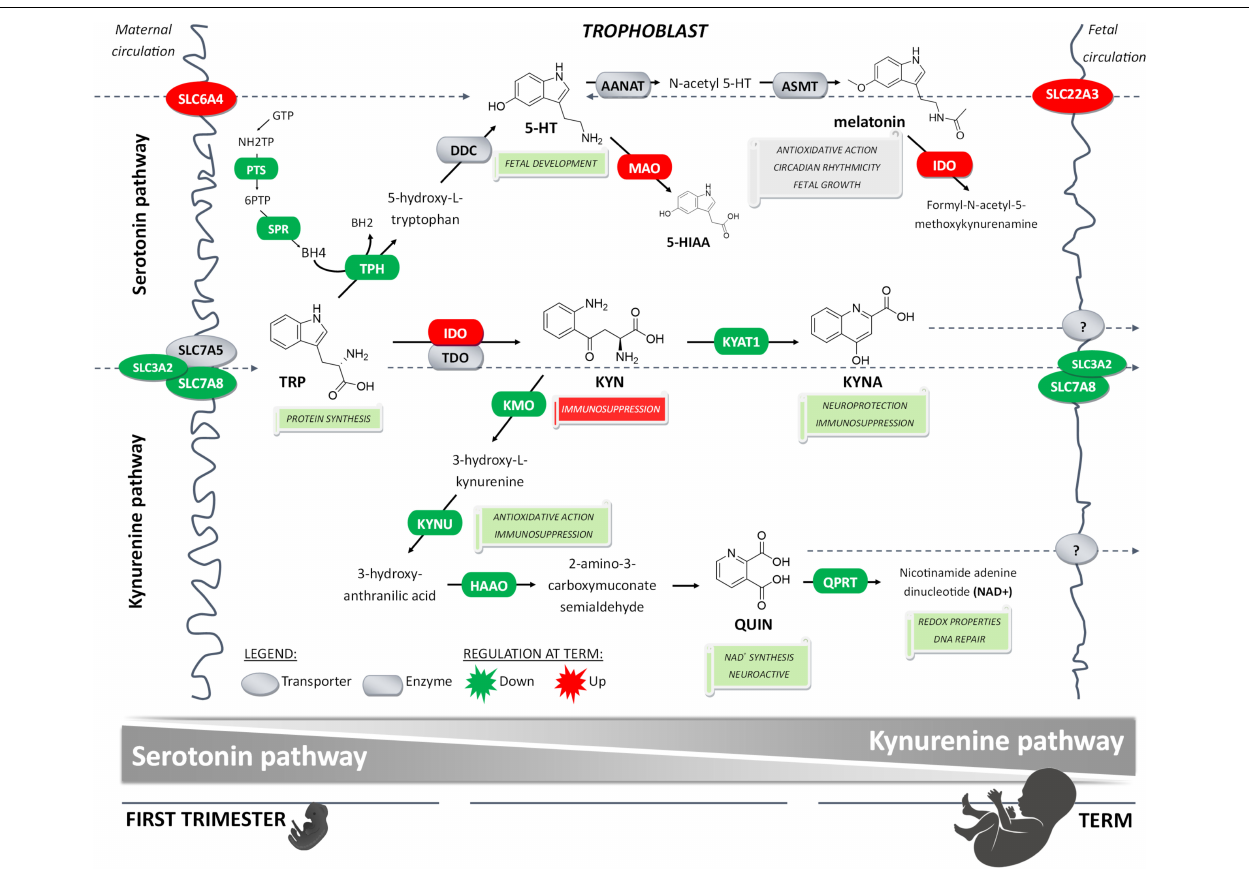
FIGURE 6 | Proposed gestational age-dependent changes in placental TRP metabolic pathways. The schematic illustration is based on gene expression studies and, in the case of rate-limiting enzymes/key transporters, also on protein, and/or functional activity. The first-trimester placenta preferentially utilizes TRP for generation of 5-HT involved in fetal development and synthesis of KYN metabolites implicated with neuroprotection, antioxidative and redox effects, and DNA repair. On the other hand, the term placenta synthesizes significant amounts of KYN important for immune regulation activities. Collectively, our findings strongly indicate gestational age-related changes in placental handling of TRP and its main metabolites, 5-HT and KYN. This may reflect the changes in placental and fetal demands for metabolites of either pathway to ensure proper embryonic and fetal development throughout pregnancy.